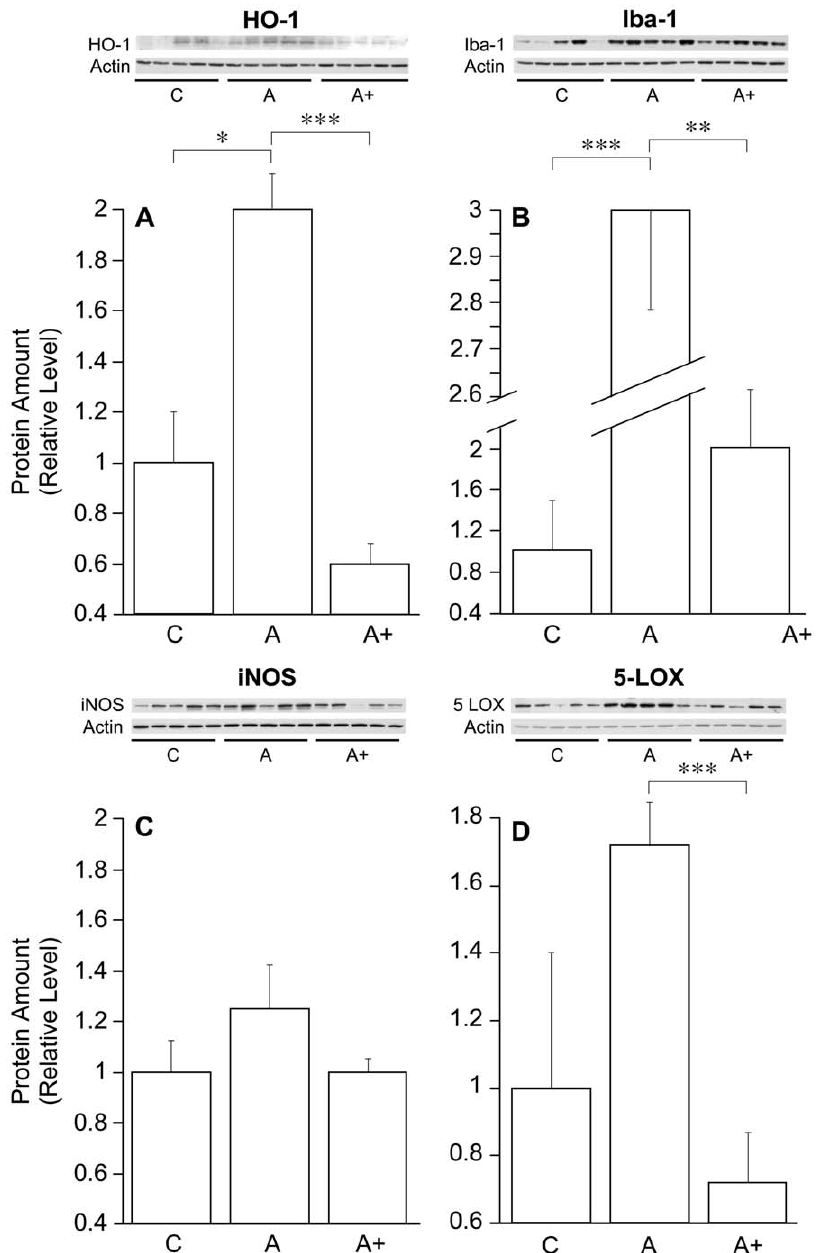
Figure 7. J147 Reduces Pro-oxidant Enzymes in the Brains of huAPP/PS1 mice. Cell lysates of hippocampal tissue from huAPP/PS1 and control mice were analyzed by western blotting and the images quantified. C=control; A=AD transgenic; A + =AD transgenic fed J147. ( A ) Heme oxygenase-1 is increased in AD transgenic mice compared to control and these levels are decreased in mice fed J147. (B) Iba-1 levels are decreased in AD transgenic mice fed J147. (C) iNOS levels are not quite significantly decreased in AD transgenic mice fed J147. P =0.053. (D) 5-LOX is significantly decreased in AD transgenic mice fed J147. * P , 0.05, ** P , 0.01, and *** P , 0.001. All data shown are means 6 SEM, n=5 per group.